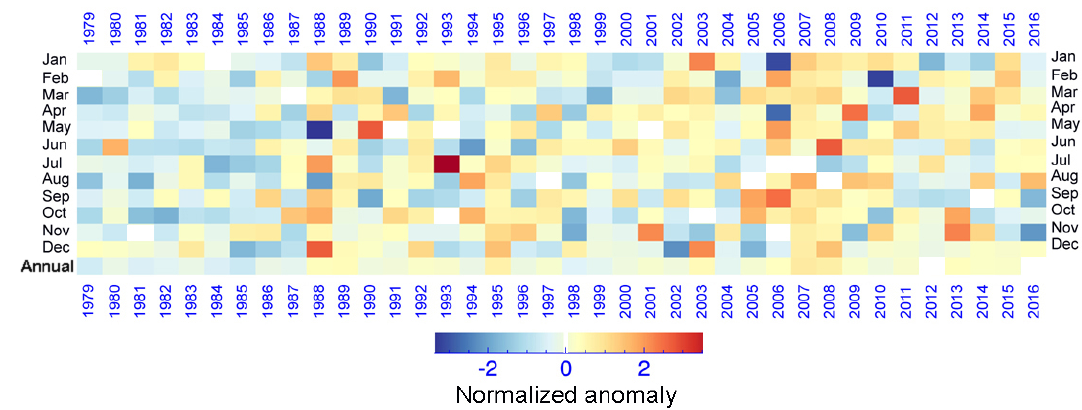
Figure 3. Normalized monthly anomaly fields of sea ice area flux. The anomaly field is calculated as the difference between the monthly estimate and the mean value of the same month computed over the period of interest. Then, the normalized anomaly field is obtained by dividing the monthly anomaly field by the standard deviation (SD) of the corresponding month over the 38-year period. The bottom row denotes the annual mean value of the normalized anomaly.